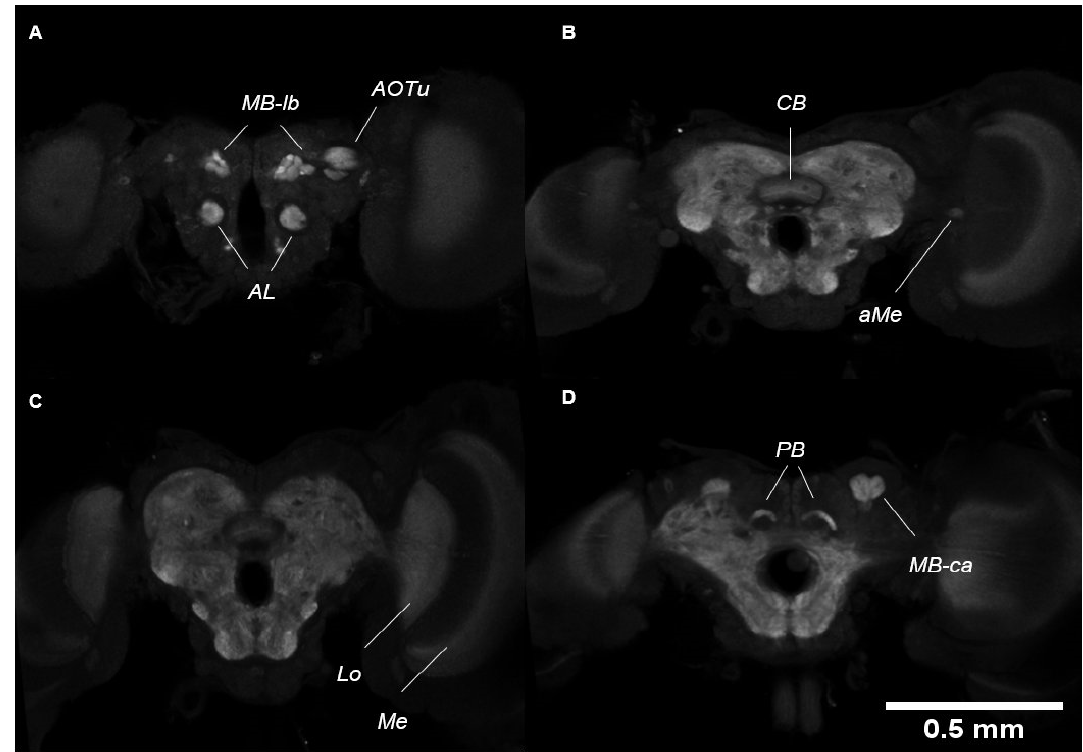
Figure 8. Visualisation of the pupal brain in different confocal sections from most anterior ( A ) to most posterior ( D ) stained with synapsin. ( A ) Mushroom body lobes (MB-lb), anterior optic tubercles (AOTu), and antennal lobes (AL). ( B ) Central body (CB) and accessory medulla (aMe). ( C ) Medulla (Me) and lobula (Lo). ( D ) Mushroom body calyx (MB-ca) and protocerebral bridge (PB).